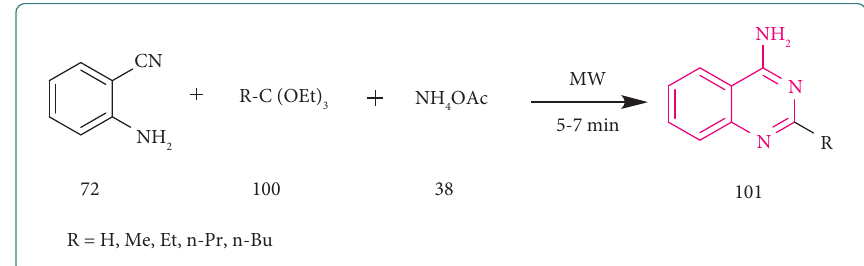
Scheme 18: Synthesis of 2-alkyl-4-aminoquinazoline derivatives using 2-aminobenzonitrile under solvent-free and microwave irradiation condition.